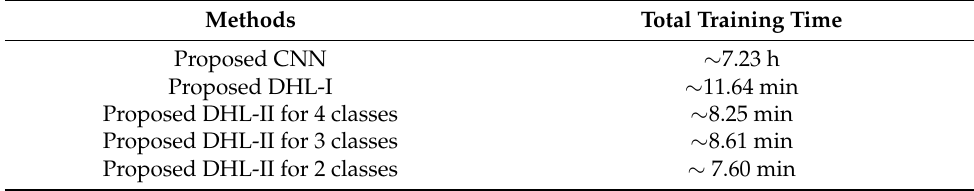
Table 8. Execution time of the two proposed DHL models using pre-trained CNN.